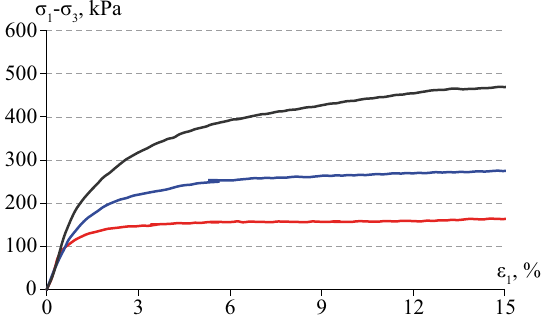
Fig. 9. Stress-strain ε 1 = ƒ(σ 1 – σ 3 ) curves (loose sand, H/D = 2): – 50 kPa; – 100 kPa; – 200 kPa